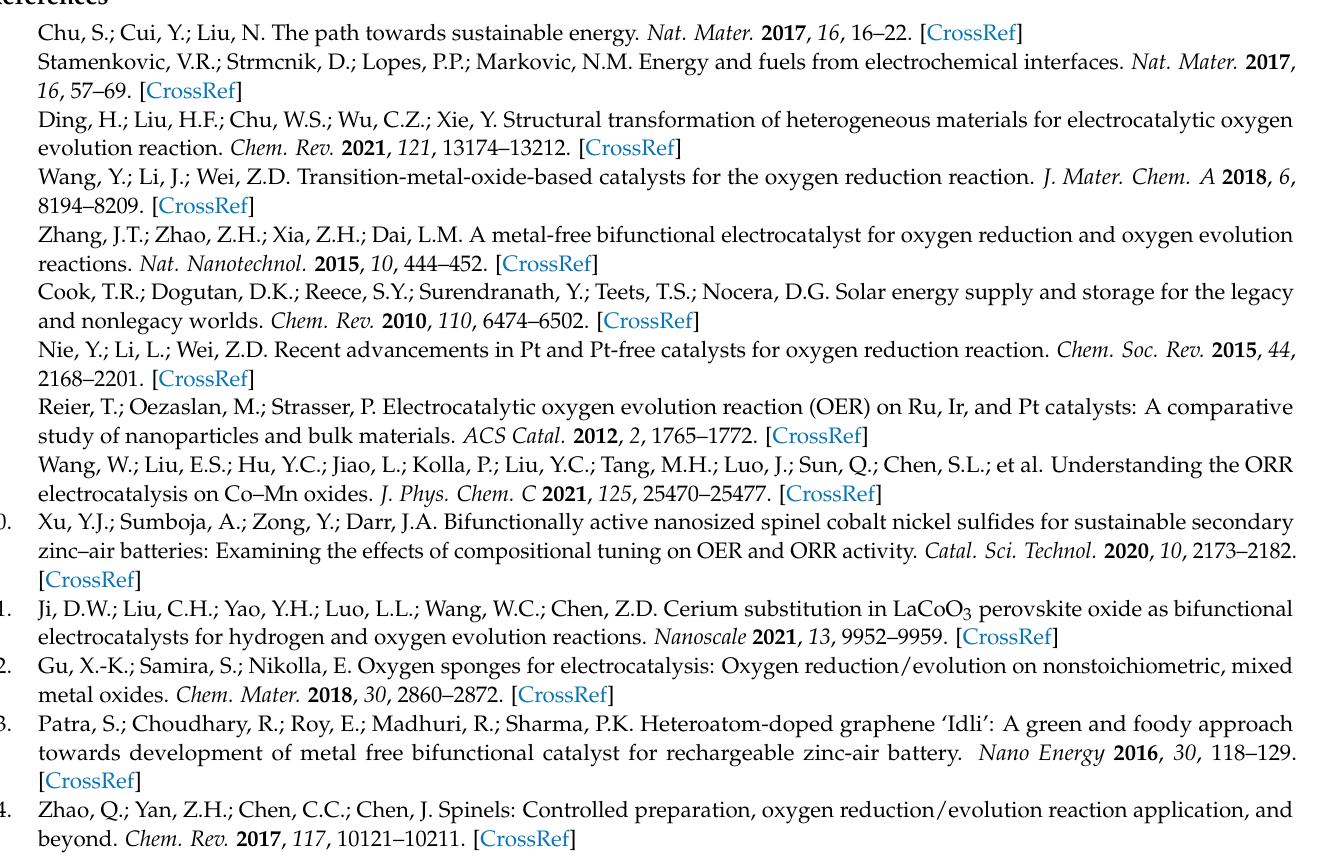
Ce-CMO-18%/MWCNTs in PBS solution (pH = 7.0) at a scan rate of 50 mV s − 1 , (b) Calculated O 2 TOF values of Ce-CMO-18%/MWCNTs. Figure S15: TEM image of the Ce-CMO-18%/MWCNTs after OER durability test. Figure S16: XPS spectra of the Ce-CMO-18%/MWCNTs before and after OER durability test. Figure S17: O 1s XPS spectra of the Ce-CMO-18%/MWCNTs before and after OER durability test. Figure S18: The cyclic voltammograms curves of (a) CMO, (b) Ce-CMO-18%, and (c) Ce-CMO-18%/MWCNTs in Ar- and O 2 -saturated 1 M KOH aqueous solution. Figure S19: (a) Oxygen reduction polarization curves for Ce-CMO-18%/MWCNTs at 0.1 M KOH at various rotations rates; (b) Koutecky-Levich plots at different potentials (0.4, 0.5, 0.6, and o.7 V vs. RHE) at a scan rate of 10 mV s − 1 . Figure S20: The chronoamperometry responses obtained on Pt/C and Ce-CMO-18%/MWCNTs at potential of 0.75 V. Figure S21: i-t chronoamperometric response for Pt/C and Ce-CMO-18%/MWCNTs in O 2 -saturated 0.1 M KOH solution with addition of methanol at 100 seconds